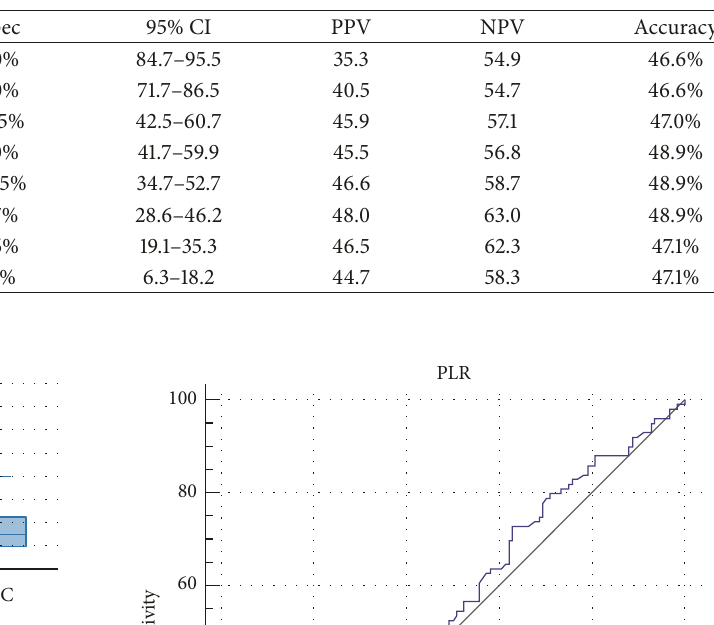
Table 4: Diagnostic accuracy analysis for platelet-to-lymphocyte ratio.